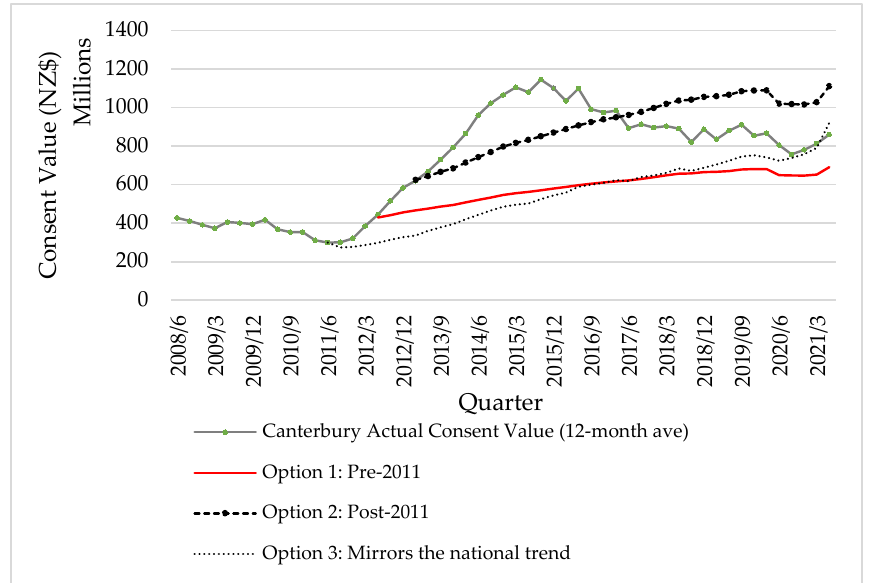
Figure 4. Normal level of building activity, Canterbury. Source : Author’s estimates.